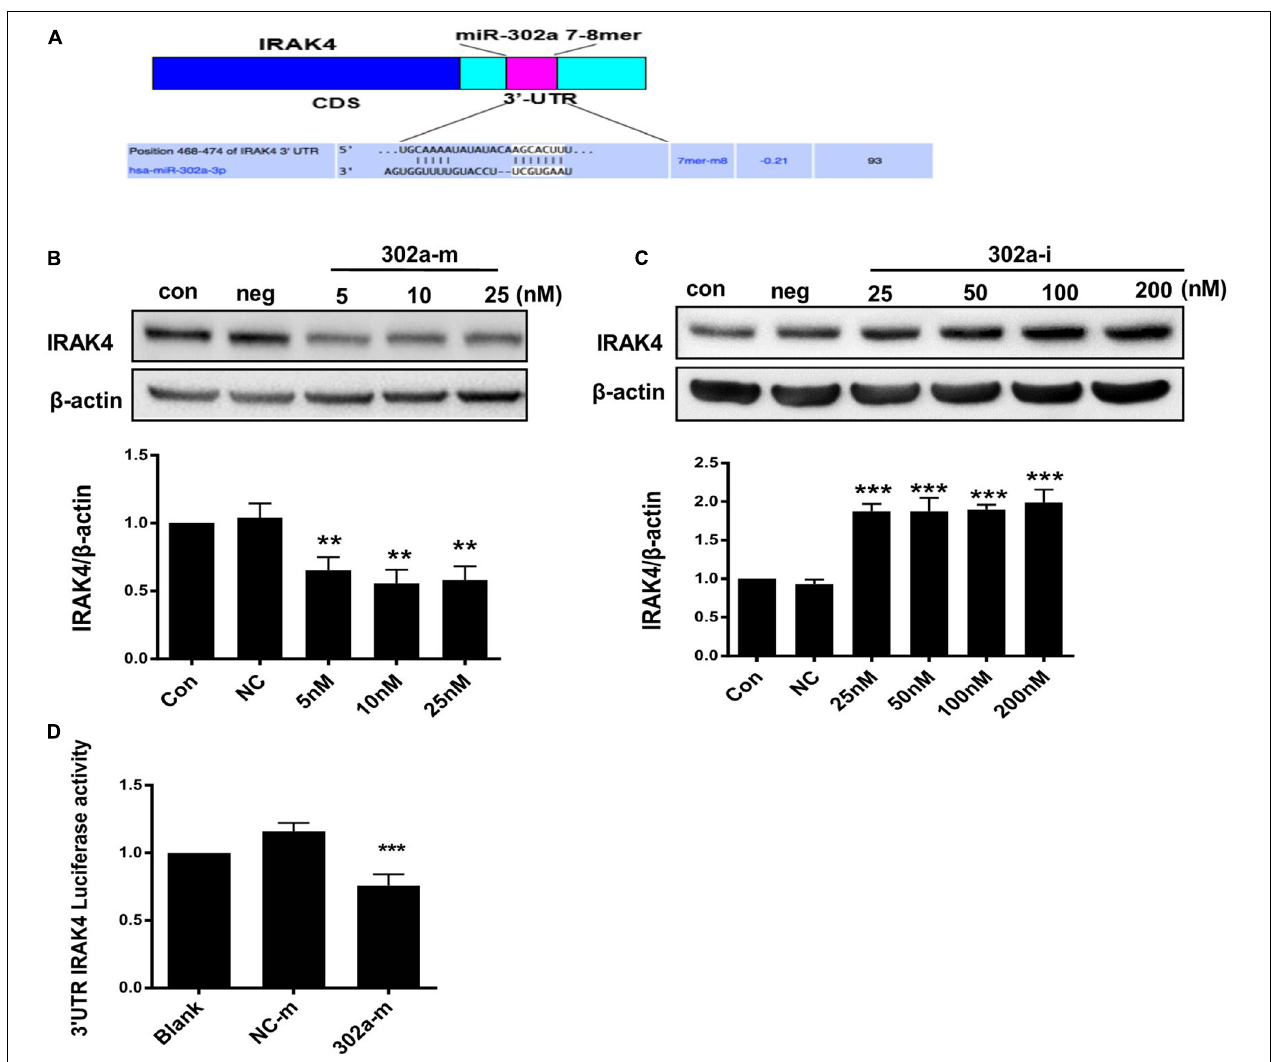
FIGURE 6 | MiR-302a regulates the IKK β –I κ B α –NF- κ B pathway by targeting interleukin-1 receptor-associated kinase4 (IRAK4). (A) Possible binding sequence of IRAK4 with miR-302a predicted by TargetScan software. The expression of IRAK4 in HUVECs transfected with miR-302a mimics (5, 10, and 25 nM) (B) and miR-302a inhibitor (25, 50, 100, and 200 nM) (C) for 48 h (** p < 0.01; *** p < 0.001 vs. Negative control; n = 5). (D) The luciferase activity of Luc-IRAK4-3’UTR in HEK 293T cells transfected with miR-302a mimics (302a-m) (*** p < 0.001 vs. NC-m; n =